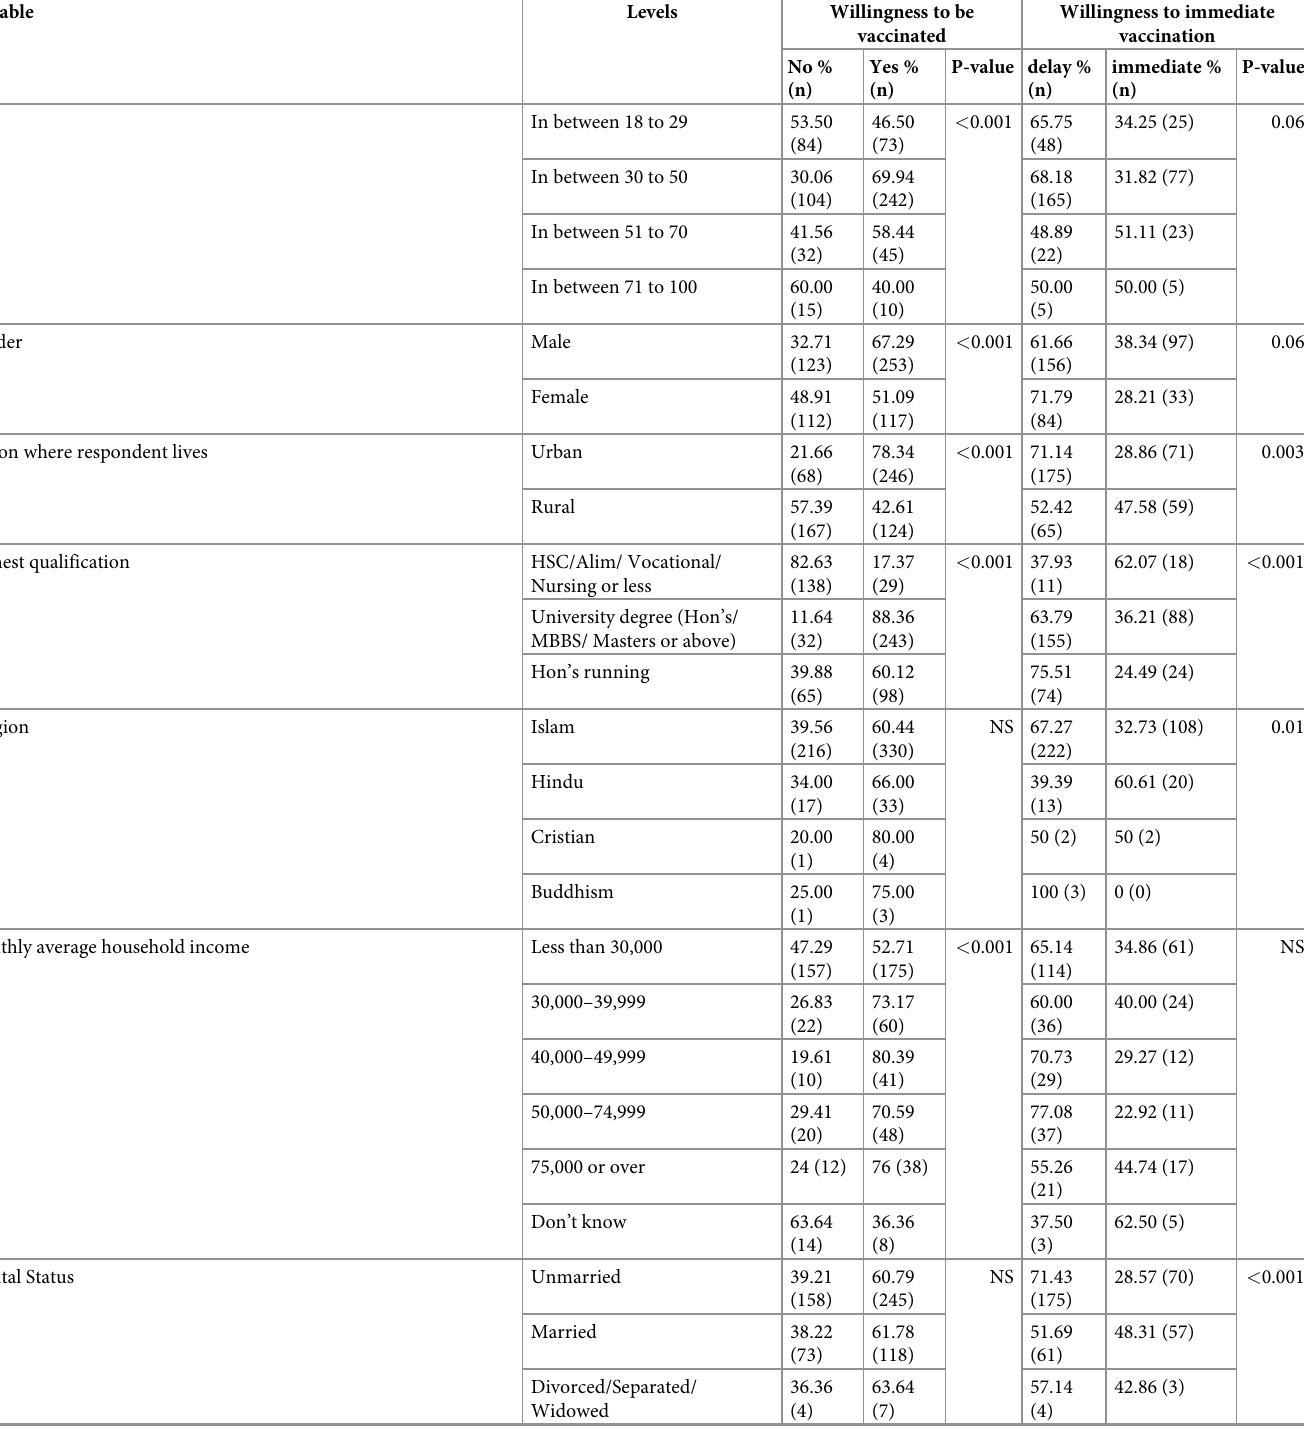
Table 4. Association of different factors with the willingness to be vaccinated and willingness to immediate